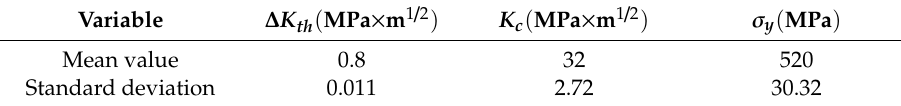
Table 2. Test data of crack growth length.